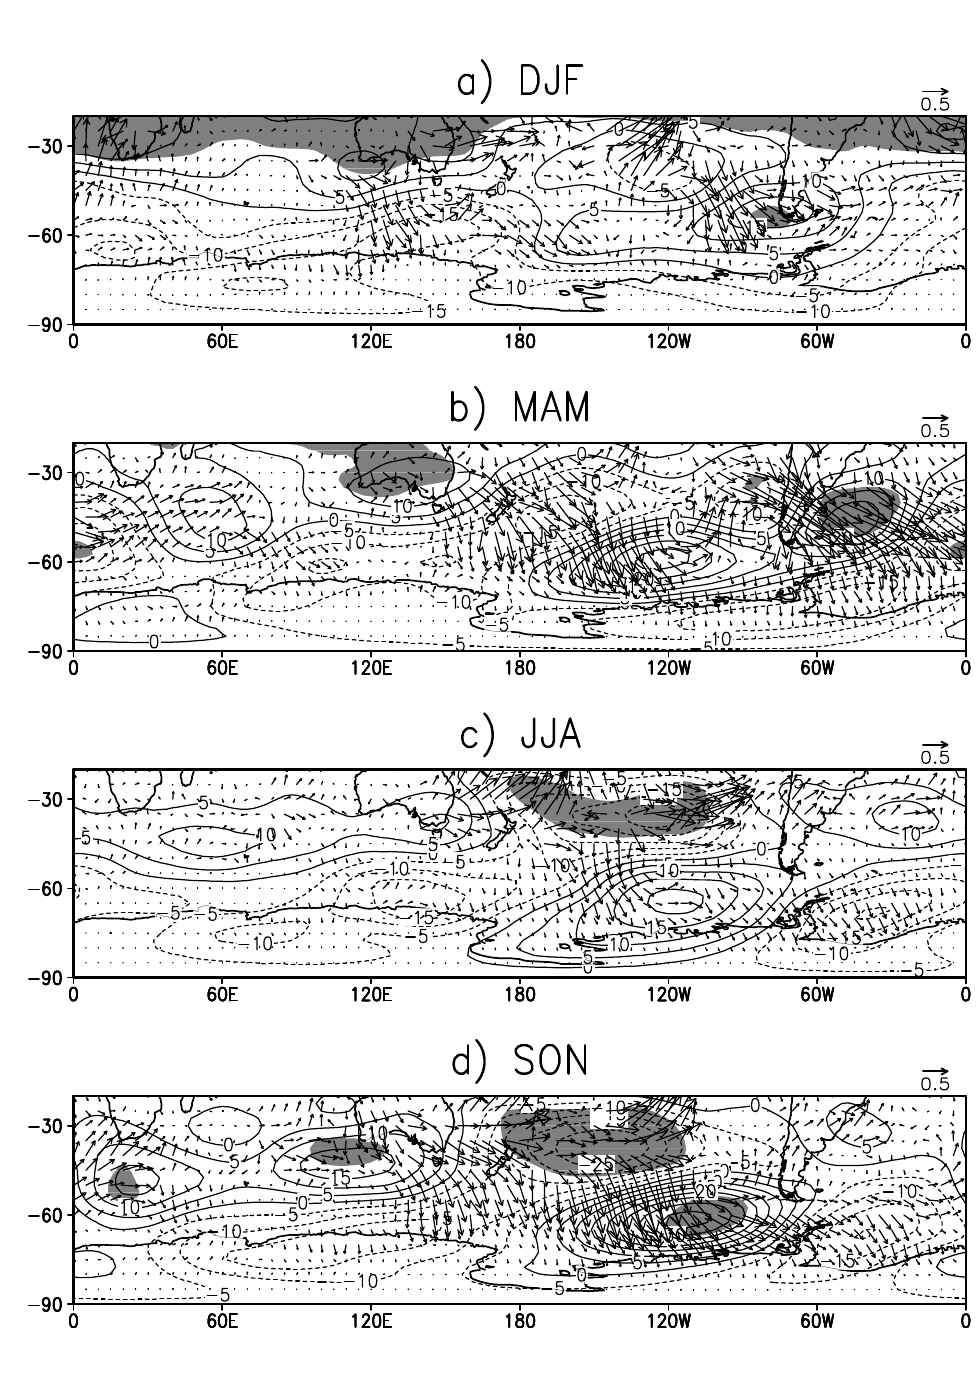
Fig. A5. Same as Fig. A3, but for 500hPa